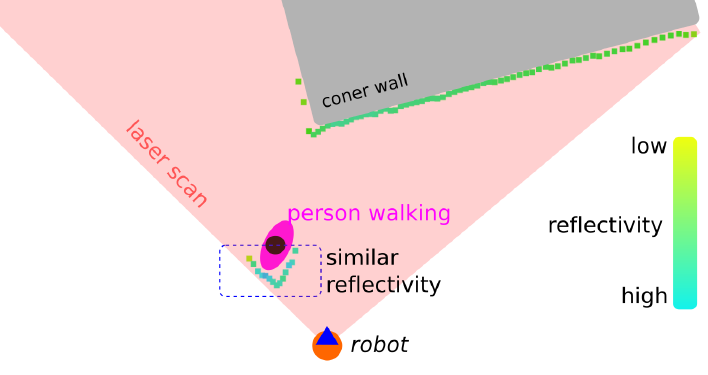
Figure 3. Example of LIDAR reflectivity in real